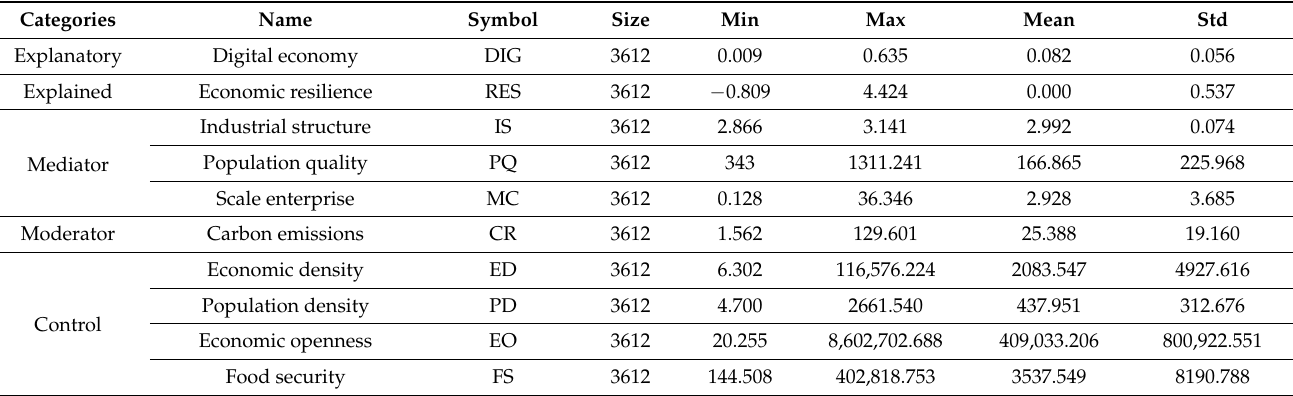
Table 2. Descriptive statistics of main